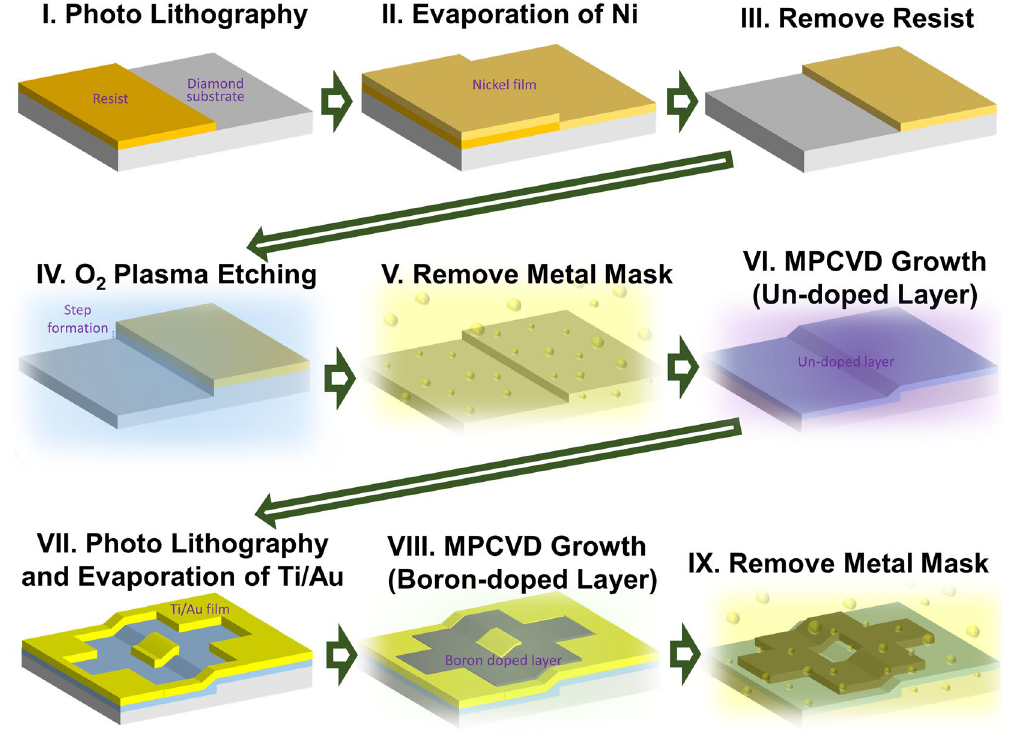
Figure 1. Fabrication process of single-crystalline boron-doped diamond Josephson junction and SQUID with regrowth-induced step edge